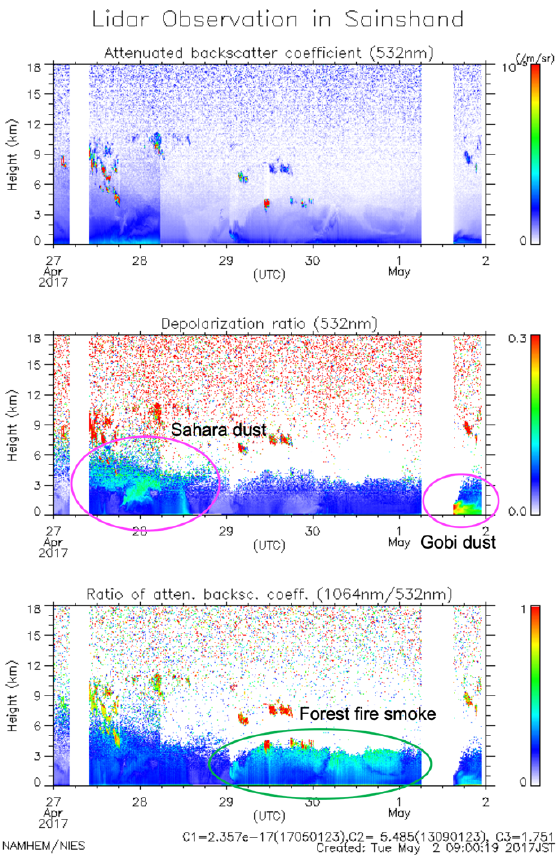
Fig.3 Time-height indications of attenuated backscatter coefficient at 532 nm (top), volume depolarization ratio at 532 nm (middle), and color ratio of attenuated backscatter coefficients at 1064 nm to 532 nm (bottom), observed in Sainshand, Mongolia in April 2017.